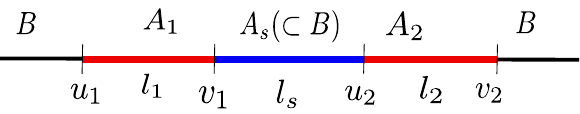
Fig. 1 Tripartite system of two disjoint intervals A 1 and A 2 , and the remainderofthesystem B ina CFT 1 + 1 .Thetwointervalsareseparated by A